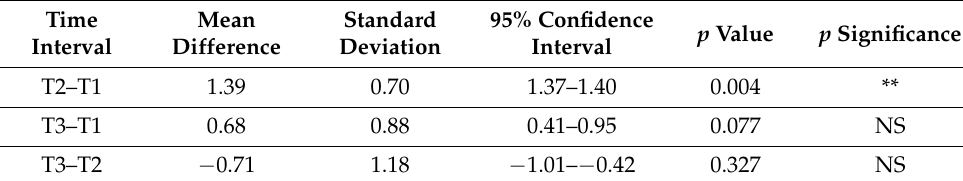
Table 7. Results of the mean differences (mm) of Nasal Width 5 in the three time